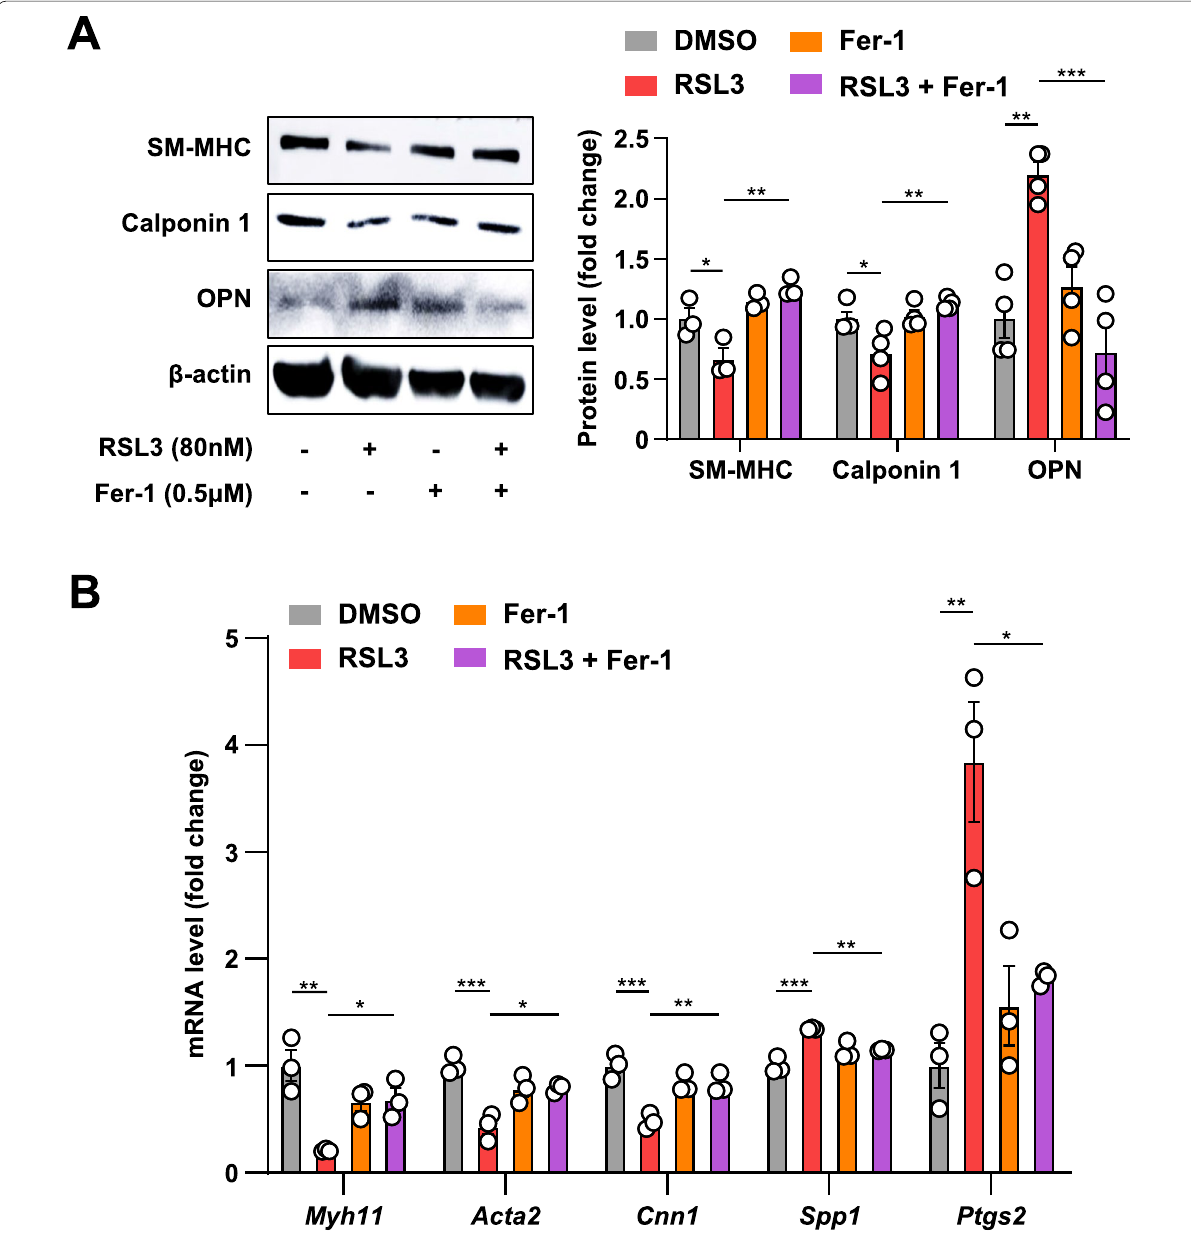
Fig. 5 Ferroptosis inhibitor Fer‑1 reverses RSL3‑induced rat VSMC phenotypic switching. A , B Rat VSMCs were pretreated with Fer‑1 (0.5 μM) for 15 min and/or RSL3 (80 nM) for an additional 24 h and subjected to the following analyses. A The representative Western blots and densitometric quantification of SM‑MHC, calponin 1, and OPN ( n 3 and 4, respectively). B qRT‑PCR analysis of Myh11 , Acta2 , Cnn1 , Spp1 , and Ptgs2 ( n = Data are presented as mean SEM, P values calculated by a one‑way ANOVA followed by Tukey’s multiple comparisons test. * P < 0.05, ** P < 0.01, ± *** P <